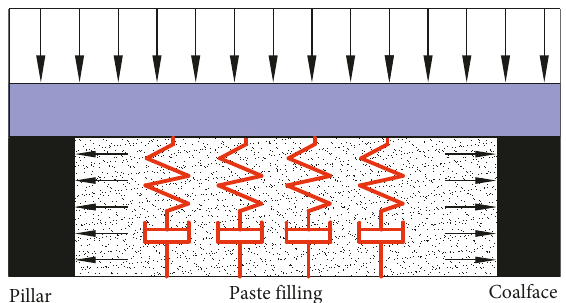
Figure 14: Supporting system of filling